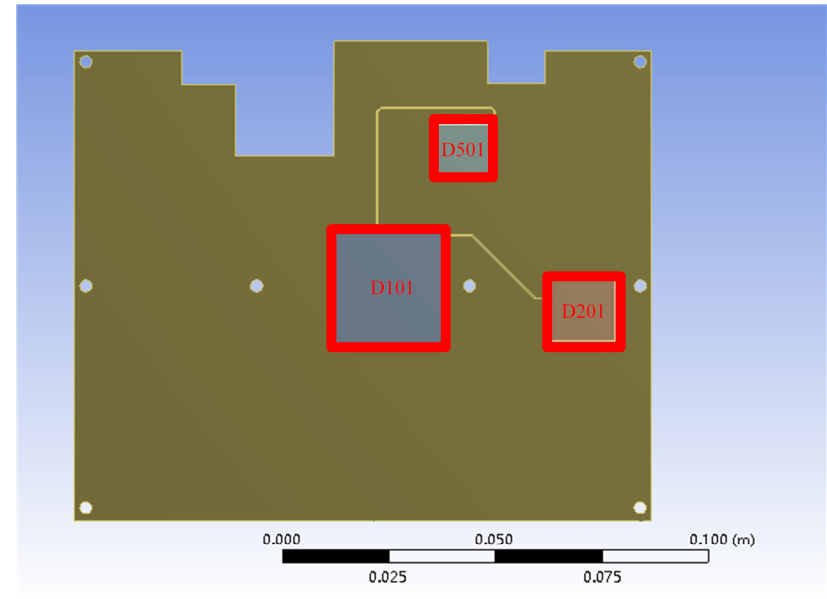
Figure 1. Structure diagram of the simulation model. Table 1. The material parameters in FEA.